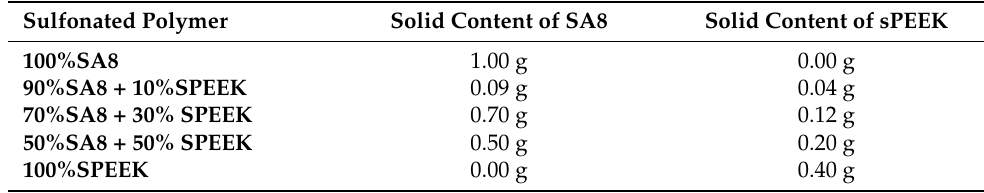
Table 2. Solid contents of SA8 and sPEEK.